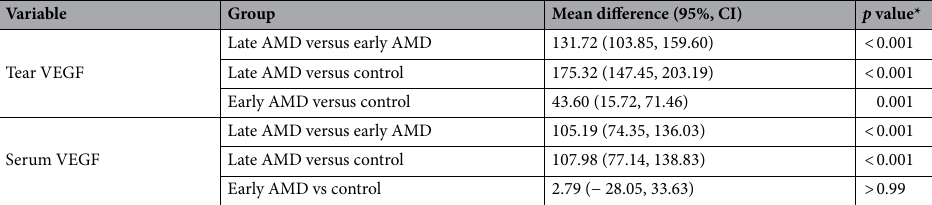
Table 3. Post-hoc comparison of mean tear and serum VEGF after adjustment. AMD Age-related macular degeneration, VEGF Vascular endothelial growth factor. *Bonferroni post-hoc comparison test, p < 0.05 was considered